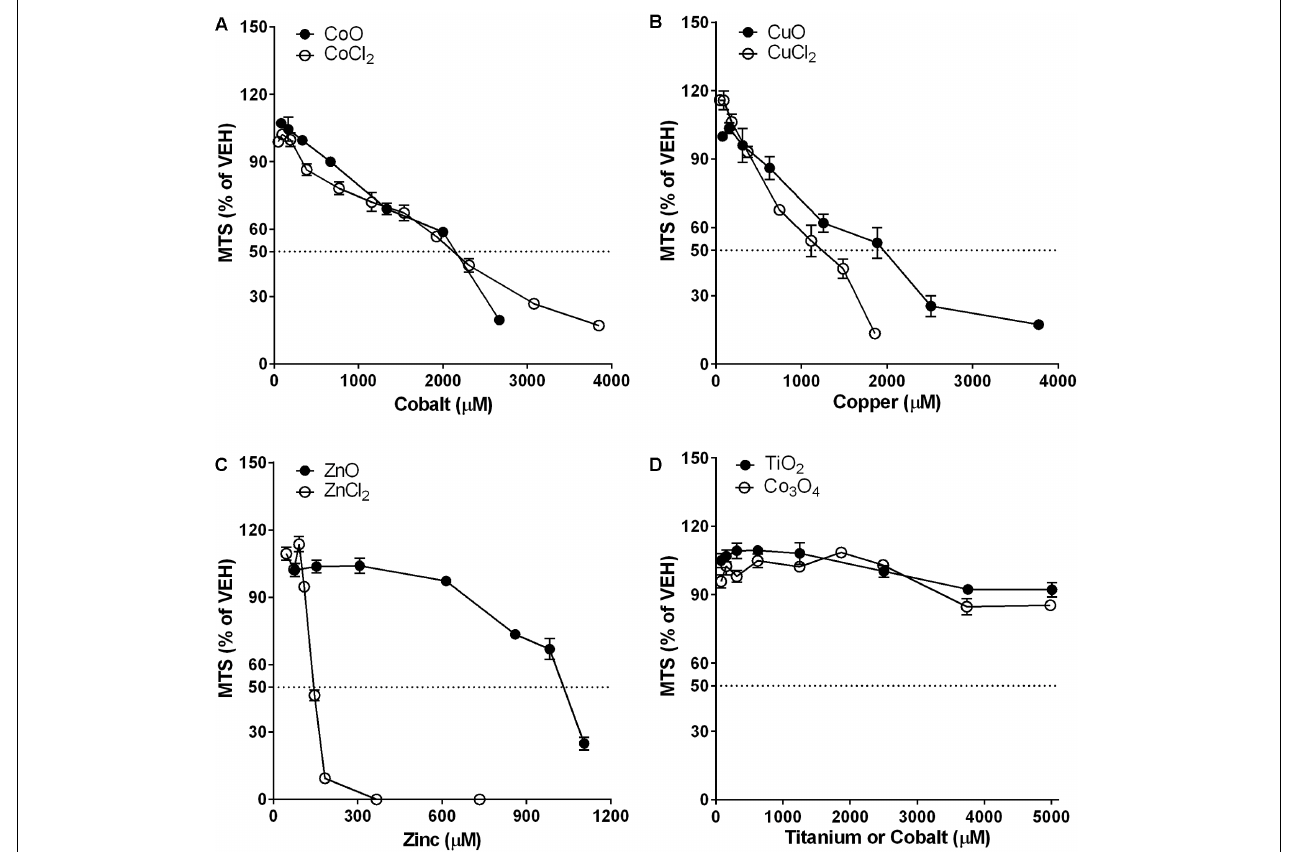
FIGURE 4 | Comparison of dose-response curves of metal-oxide NPs and their respective constituent metal chlorides in A549 cells. Cytotoxicity was measured by MTS assay. Note that the mass doses were converted into molar concentrations. (A) CoO NP showed a similar trend in the dose-response curve and almost identical cytotoxic potential compared to CoCl 2 . (B) CuO NP showed a similar trend in the dose-response curve but less cytotoxic potential than CuCl 2 . (C) ZnO NP showed a completely different trend in the dose-response curve with much less cytotoxic potential than ZnCl 2 . (D) Biopersistent TiO 2 and Co 3 O 4 NPs showed no cytotoxicity within the tested doses ( < 400 µ g/mL; 5008 µ M for TiO 2 and 4983 µ M for Co 3 O 4 ). Values are mean ± SEM from eight independent